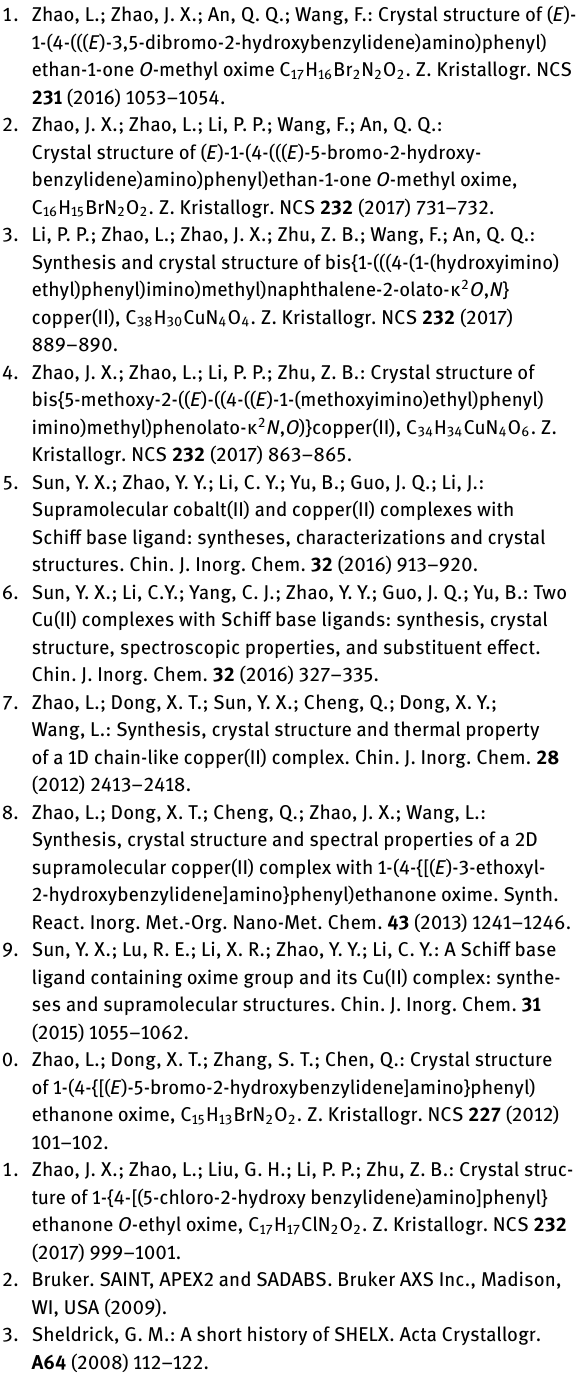
Table 2: Fractional atomic coordinates and isotropic or equivalent isotropic displacement parameters (Å 2